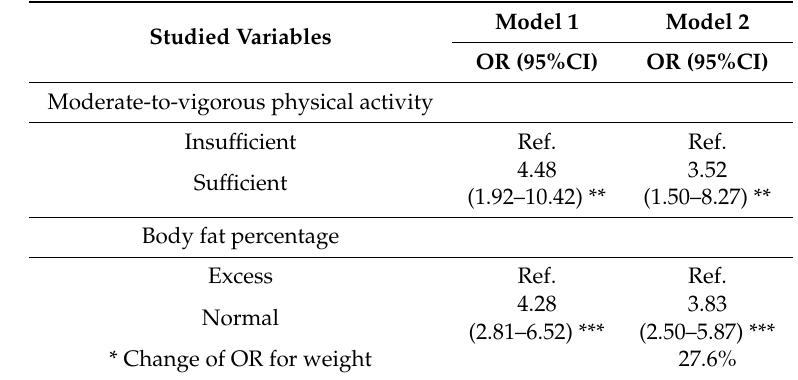
Table 3. The association of moderate-to-vigorous physical activity with self-rated health, adjusted for age and gender, and additionally adjusted for body fat percentage from logistic regression models (odds ratios—OR / 95% confidence